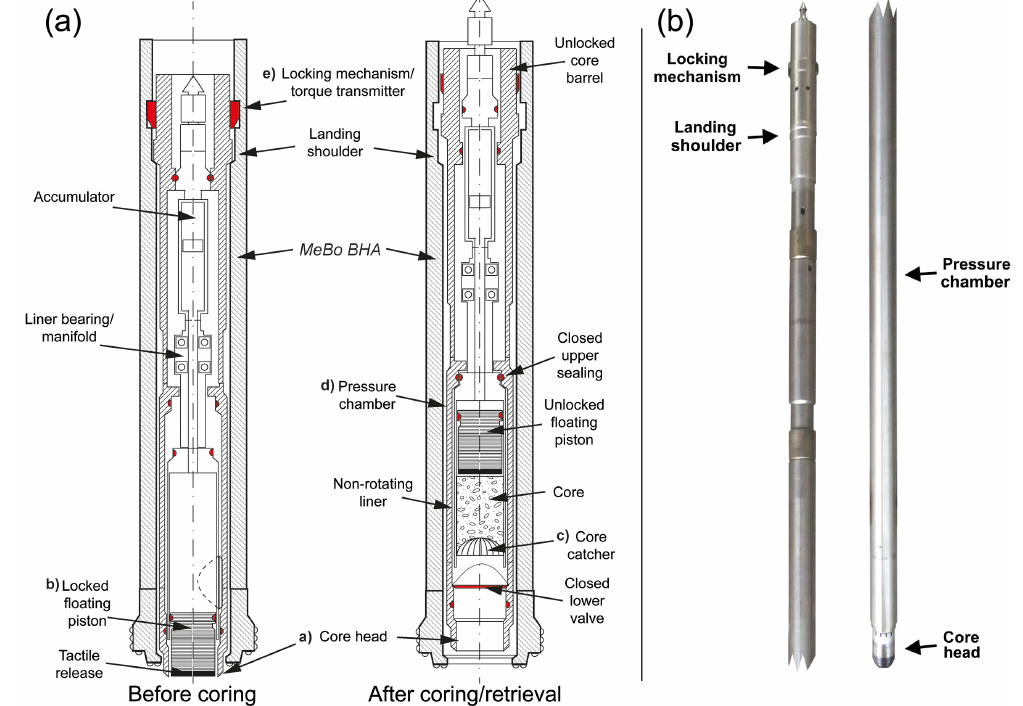
Figure 1. (a) Scheme and working principle of the MeBo pressure vessel (MDP; not in scale). BHA = bottom hole assembly. (b) Photograph of the MDP (left: top part; right: bottom